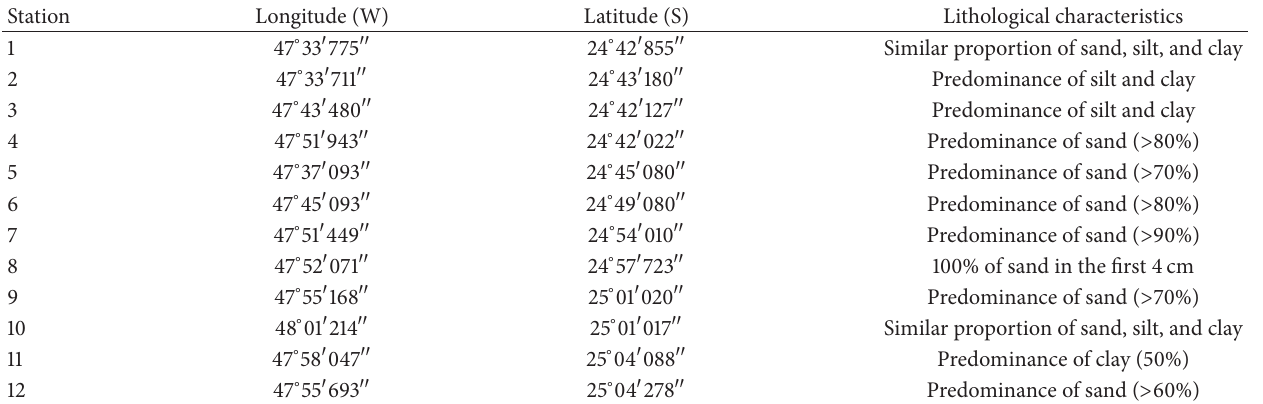
Table 1: Geographical locations and lithological characteristics for the 12 sampling sites in the Canan´eia-Iguape estuarine-lagoonal system.